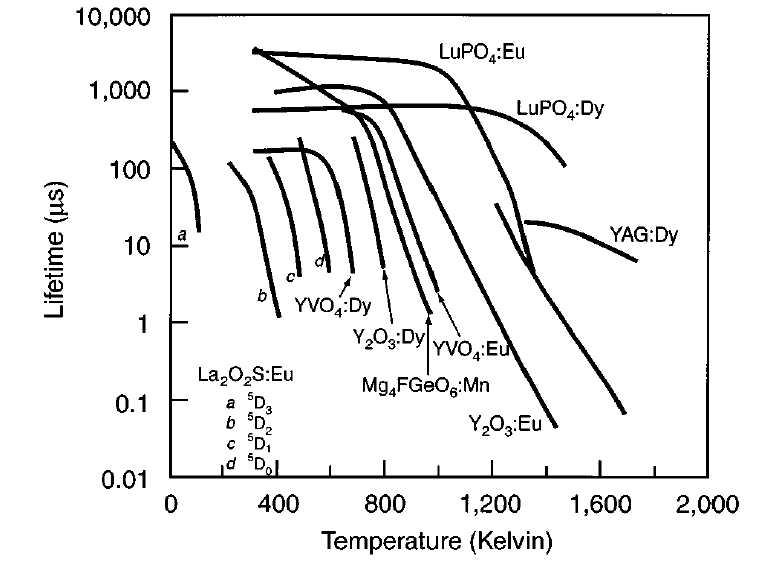
Figure 14. Lifetime of phosphors vs. temperatures. Taken from Allison and Gillies